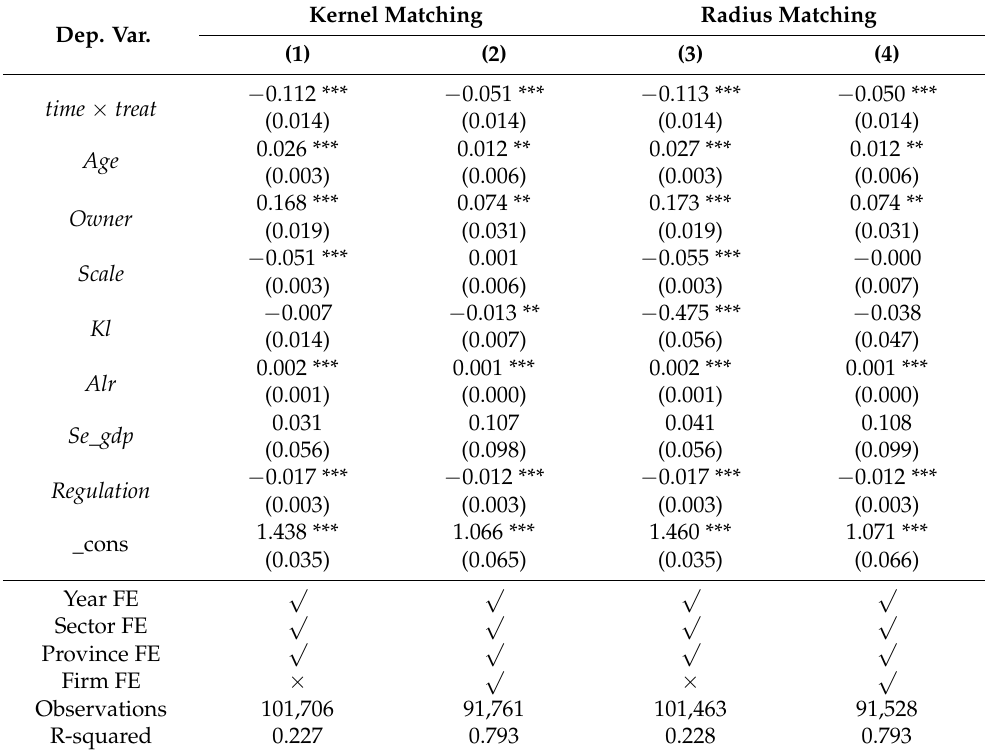
Table 10. PSM-DID. Dep.